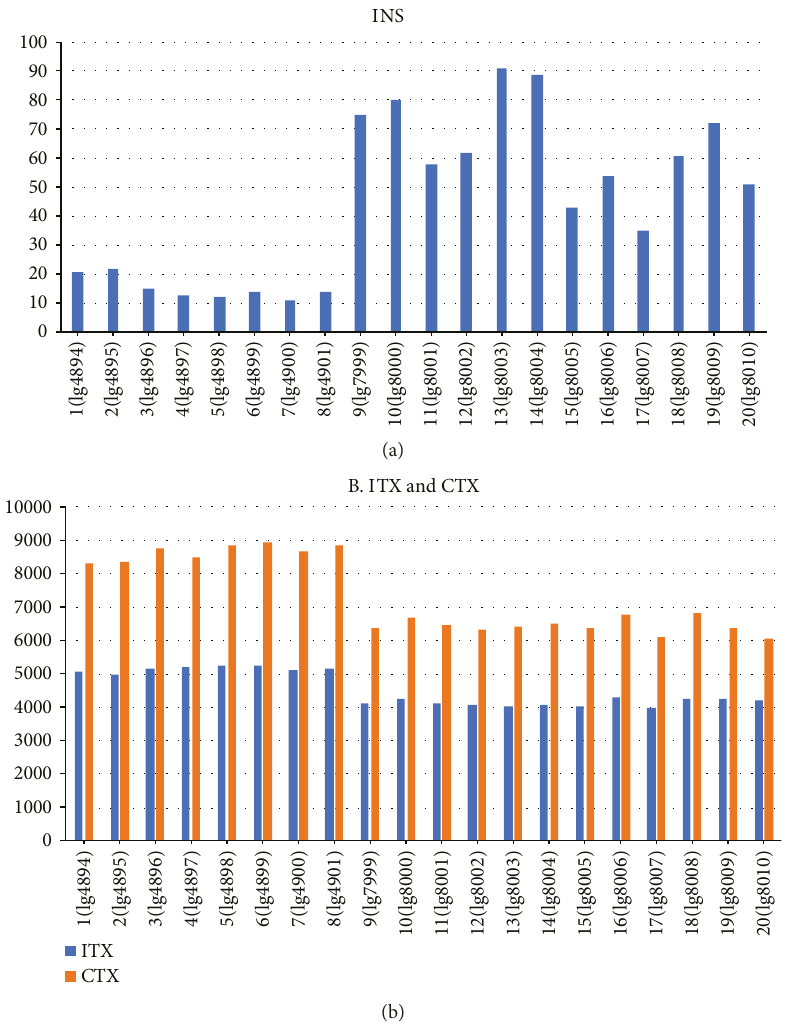
Figure 2: Comparison of structural variations in two greater amberjack populations. Greater amberjack samples 1 – 8 were captured in the sea near Kochi Prefecture, Japan. Greater amberjack samples 9 – 20 were captured in the sea near the Chinese Hainan Islands. (a) Number of insertions (INS) and (b) number of intra- (ITX) and inter- (CTX) chromosomal translocations detected in the 20 genomes. The vertical axis shows the number of structural